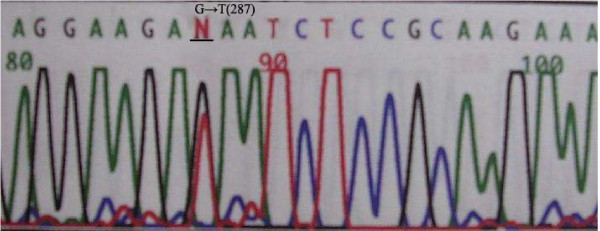
Representative tranversion of p53 exon 8 (G → T) found in cholangiocarcinoma.